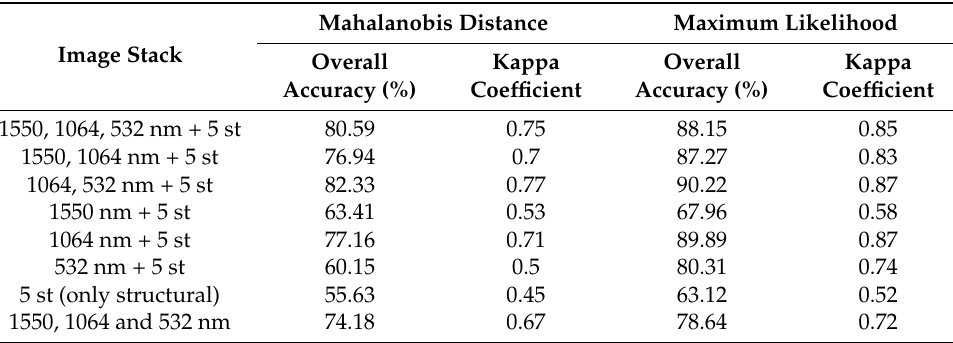
Table 4. Accuracy assessment results from ground cover classification